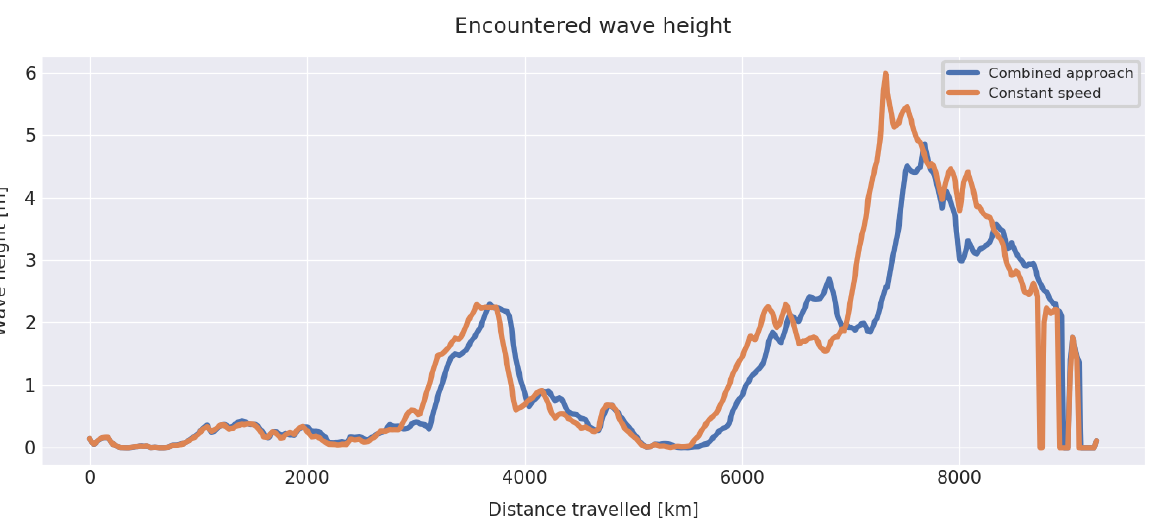
Figure 7. Comparison of encountered wave heights during example journey with constant speed and optimised